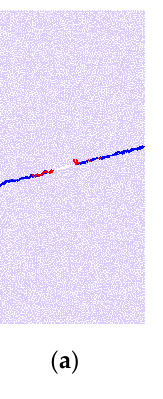
Figure 9. Numerical results of sandstone specimens: ( a ) β = 15 ◦ ; ( b ) β = 30 ◦ ; ( c ) β = 45 ◦ ; ( d ) β = 60 ◦ ; ( e ) β = 75 ◦